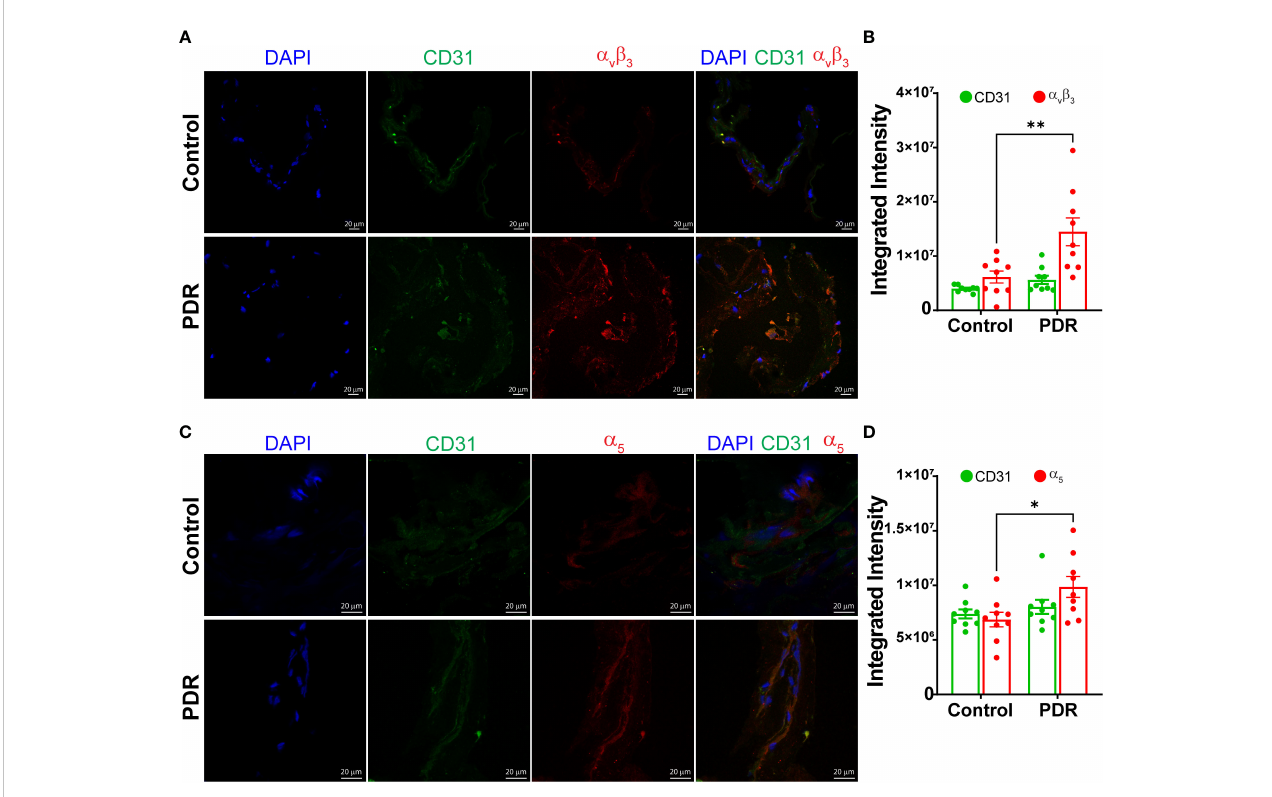
FIGURE 2 Increase in an integrin a v b 3 and a 5 expressions in FVM of PDR subjects. Representative photomicrographs showing staining and bar chart quantifying b a fl uorescence intensity for a v 3 (A, B) and 5 (C, D) integrins in the FVM membranes of PDR subjects and control (macular pucker) individuals n=9 (3 images X 3 independent biological replicates). *p<0.05,